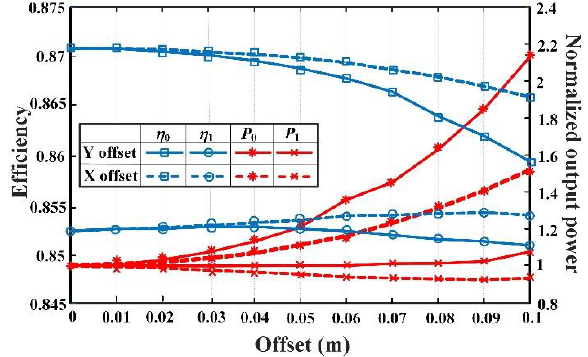
Figure 12. Comparison of efficiency and output power.